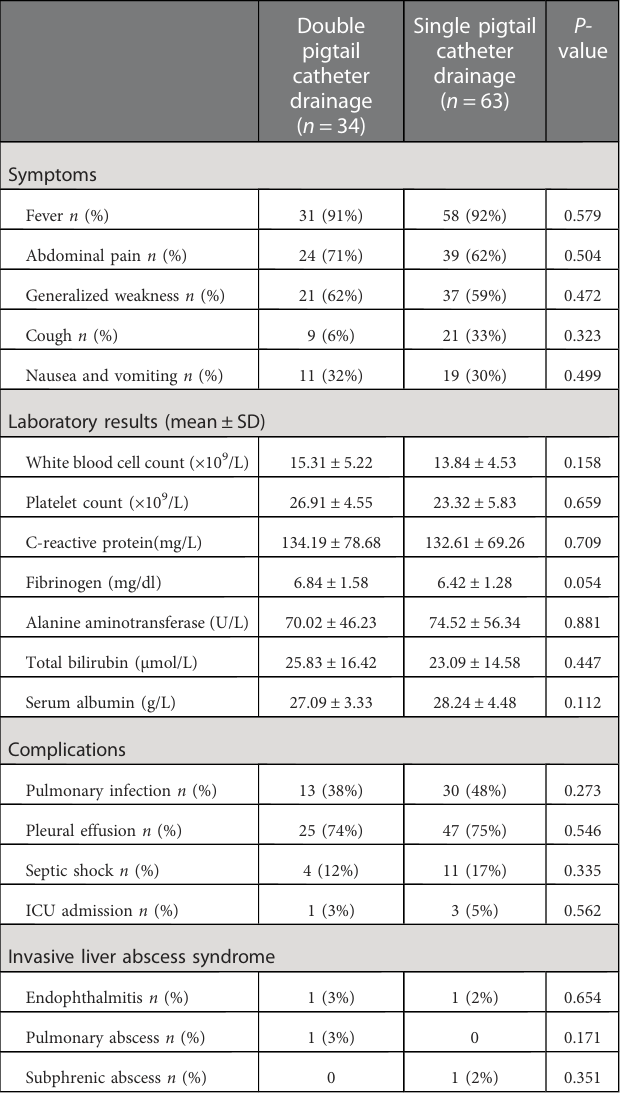
TABLE 2 Clinical symptoms, laboratory tests, and complications.